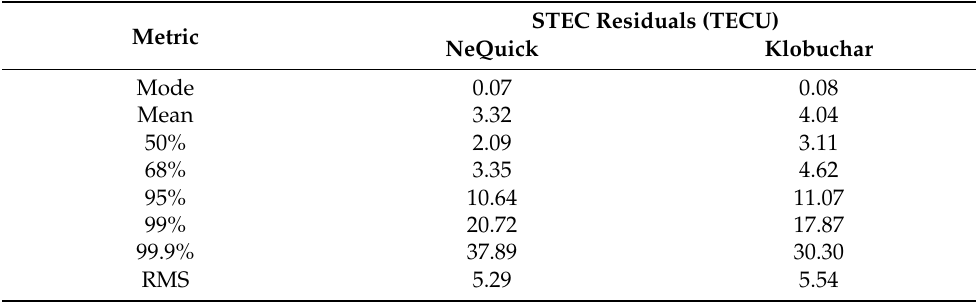
Table 3. Results of the consistency test between unambiguous and unbiased reference ionospheric values and the prediction computed by Galileo and GPS